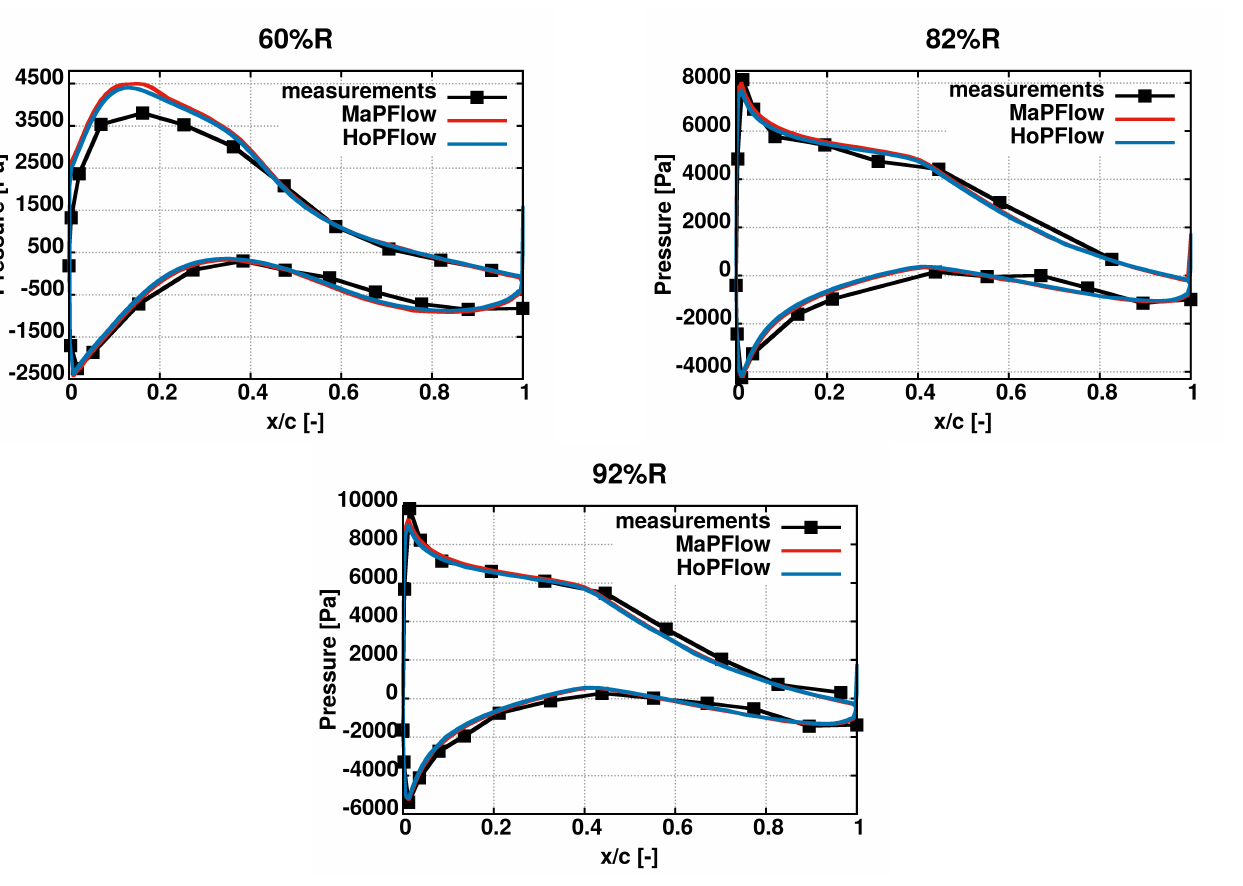
Figure 10. Pressure distribution. Comparison between experimental measurements and predictions by different computational